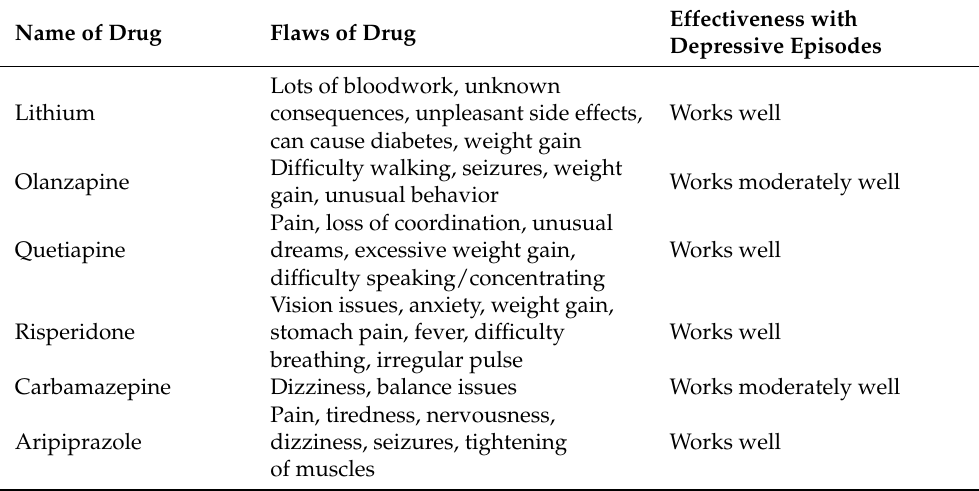
Table 1. Drugs currently used to treat Bipolar Disorder are classified to look at their functions, flaws, effectiveness, etc. This was completed before receiving data from the text-mining and organizing them (Table 2), in which the drugs found were based on manual research in PubMed.